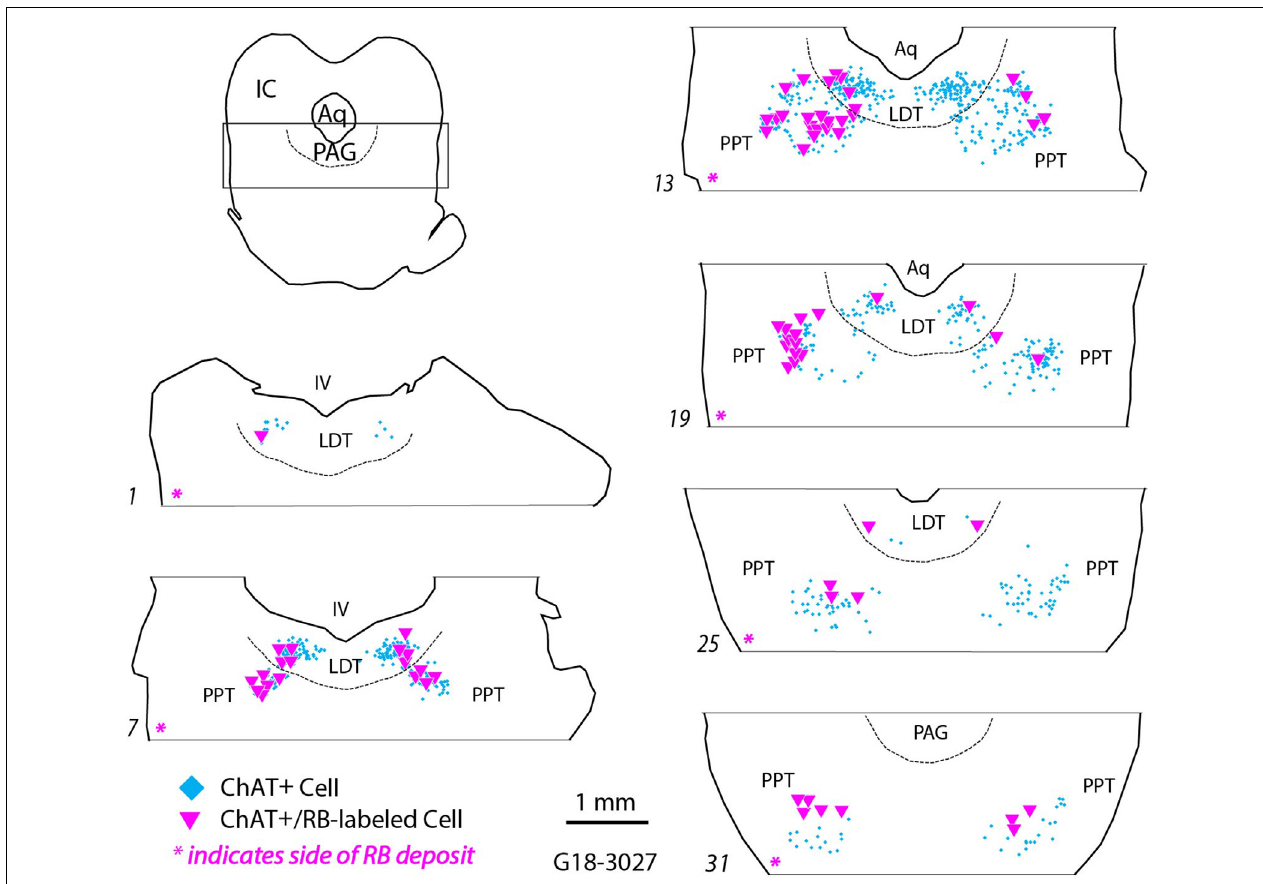
FIGURE 3 | Retrogradely labeled cholinergic cells (magenta triangles) were located in the pontomesencephalic nuclei ipsilateral and contralateral to an injection of red RetroBeads in the left SOC. Each symbol represents a single labeled cell. ChAT+ cells that did not contain RetroBeads are illustrated (cyan diamonds) to indicate the extent of the pedunculopontine and laterodorsal tegmental nuclei (PPT and LDT, respectively). Numbered sections are arranged from caudal to rostral and represent the dorsal tegmental region (indicated by the rectangle in the orientation section). The dashed line indicates the ventral border of the periaqueductal gray (PAG). The magenta asterisk at the bottom of each section outline indicates the side ipsilateral to the RB deposit in the SOC. Aq, cerebral aqueduct; IC, inferior colliculus, IV, fourth ventricle.